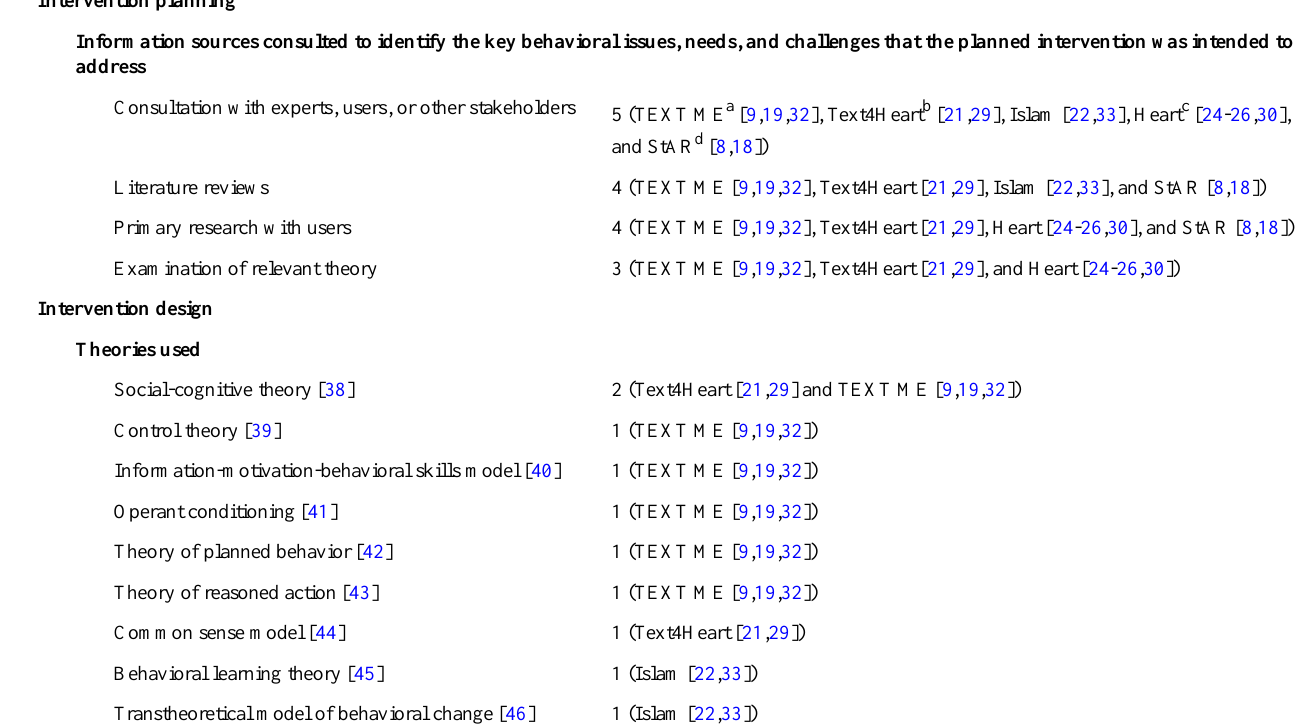
Table 1. Frequency of the different methods used to inform the development process of the interventions